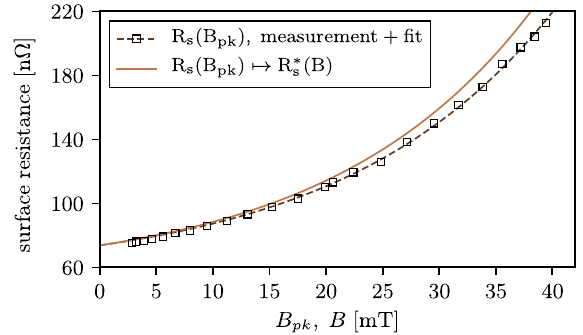
FIG. 4. Surface resistance of a LHC accelerating cavity at 4.5 K and at 400 MHz. In black, the measurement data taken from [26] as a function of the peak magnetic field B pk . In dashed brown, an exponential curve fit of the measurements and in light brown, the corresponding localized surface resistance as a function of the present magnetic field B .